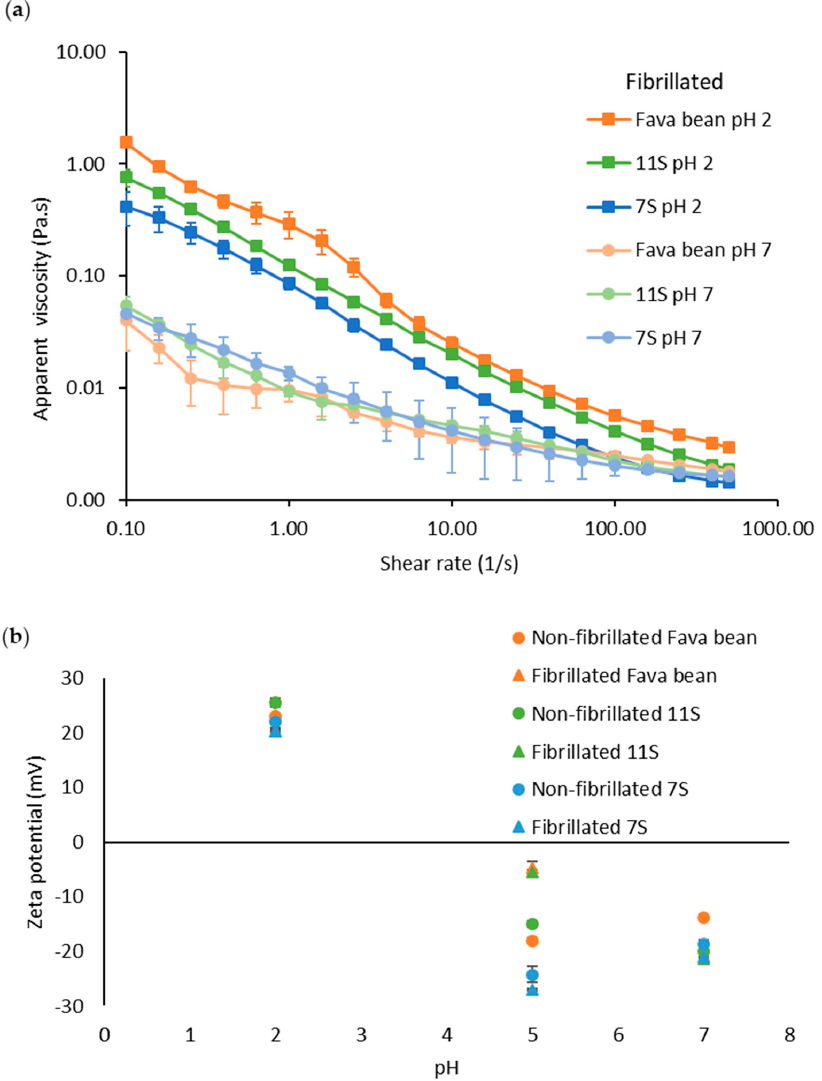
Figure 4. ( a ) Apparent viscosity versus shear rate (0.1–500 s − 1 ) for fibrillated protein from fava bean, 11S, and 7S at pH 2 (squares) and pH 7 (circles). All samples were at a concentration of 10 mg/mL. ( b ) Z potential of non ‐ fibrillated and fibrillated fava bean (orange), 11S (green), and 7S (blue) protein at pH 2, 5, and 7. The error bars in figure ( a , b ) refer to the standard deviation. Fibrillated fava bean protein had the highest apparent viscosity at pH 2 (Figure 4), which was probably due to residues of polysaccharides in the protein isolate [24] gener ‐ ating aggregates (see Figure 1). This was also confirmed with a higher consistency index for fibrillated fava bean than 11S or 7S at pH 2 (Table 1). When the pH was increased from 2 to 7, the viscosity of all fibrillated samples dropped (Figure 4), which was also correlated with a lower consistency index for all samples at pH 7 (Table 1). All samples at both pH 2 and pH 7 had a shear thinning behaviour, which was confirmed with a negative flow behaviour index (Table 1). This was probably because the PNFs were degraded to smaller particles (see Figure 3d–f). In an earlier study by our group investigating the viscosity of